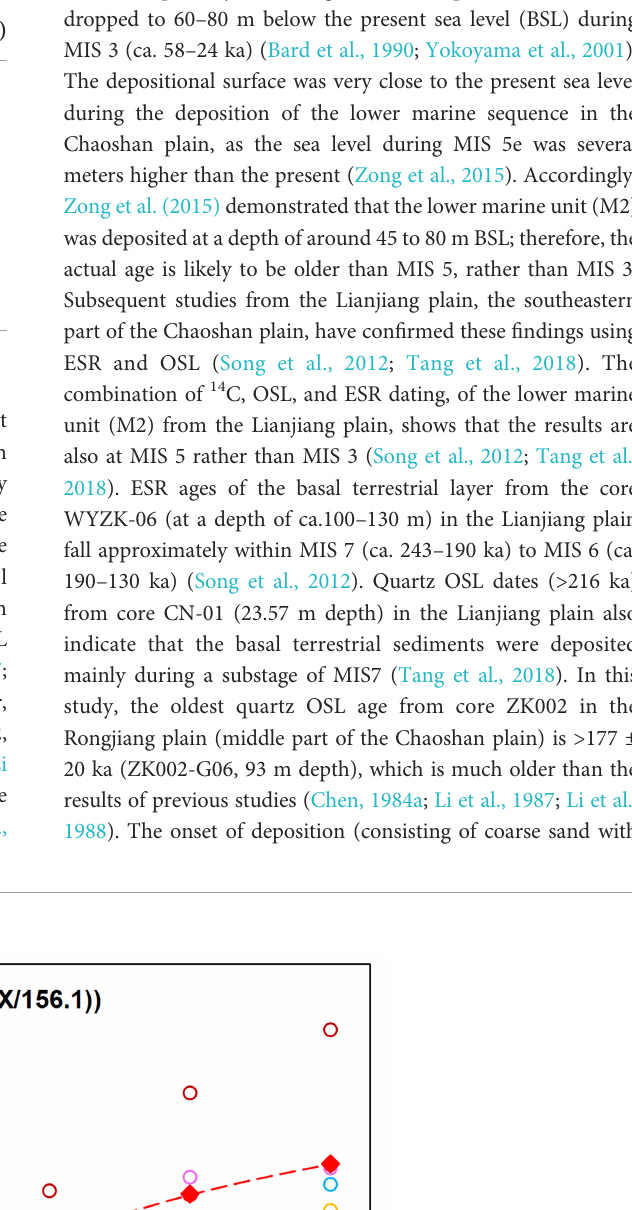
TABLE 3 Values of D 0 and 2*D 0 for samples from core ZK001 and ZK002.